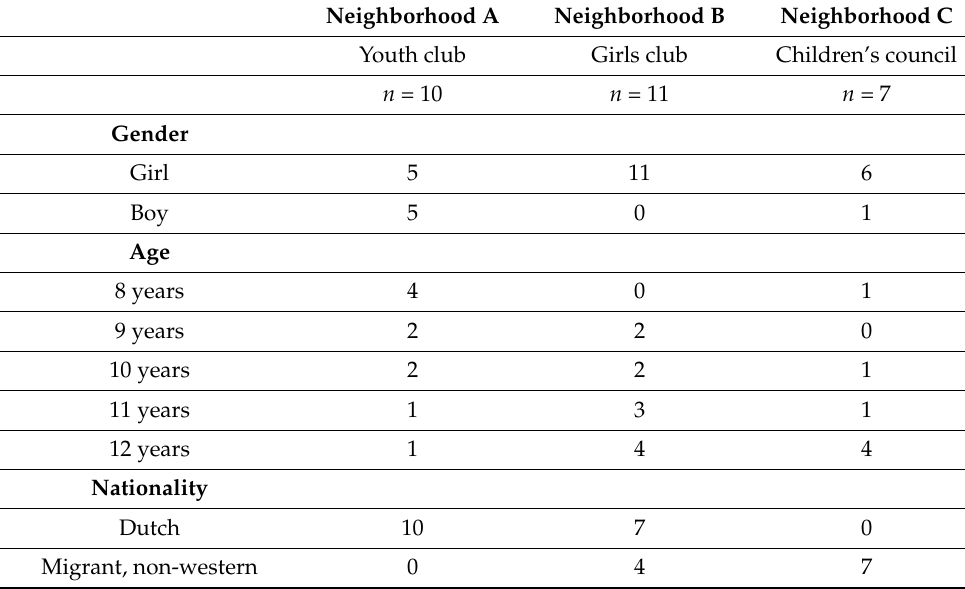
Table 1. Characteristics of participating